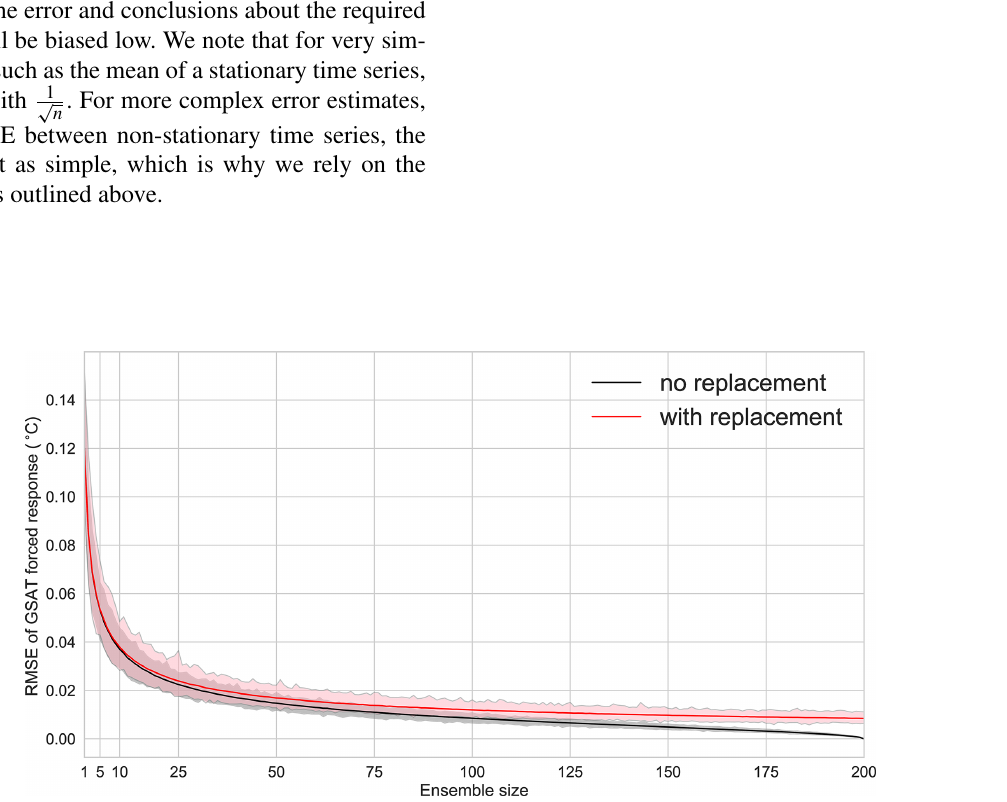
Figure A1. Sampling with or without replacement affects the error estimate and therefore the estimate for the required ensemble size. The black line shows the mean RMSE for GSAT for ensemble sizes from 2 to 200. The reference is the 200-member mean from Fig. 1, and the RMSE is computed for all 1000 samples. The shaded area shows the range of RMSE values for individual samples; the solid line shows the mean RMSE. The red line and shading show the RMSE for ensemble sizes from 2 to 200, but samples are generated by allowing sampling with replacement.